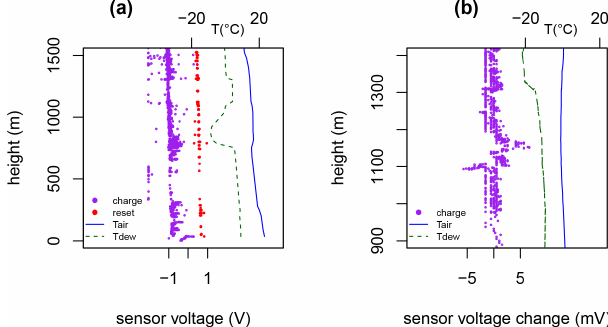
Figure 9. Vertical soundings from Reading on (a) 24 August 2000 and (b) 3 March 2004. Points show the recovered sensor voltage (scale on lower horizontal axis), with full-scale pulses highlighted in red in panel (a) . Solid blue lines and dashed dark green lines show the air temperature and dew-point temperature (temperature scale on upper horizontal axis). (Adapted from Harrison, 2001,